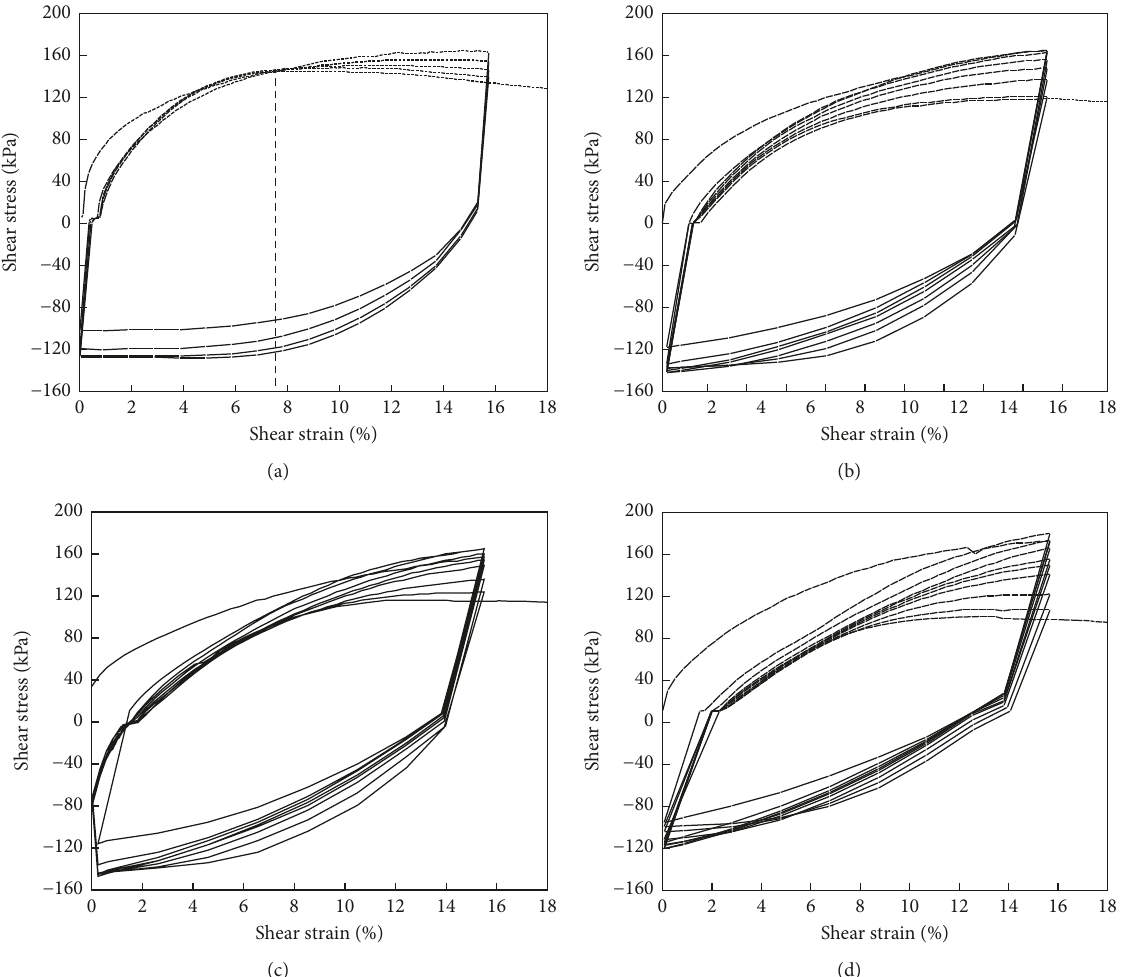
Figure 11: Variations of shear stress versus shear strain for mixtures under vertical pressure of 200kPa. (a) Clayey soil. (b) C C STC � 20%. (d) C STC �